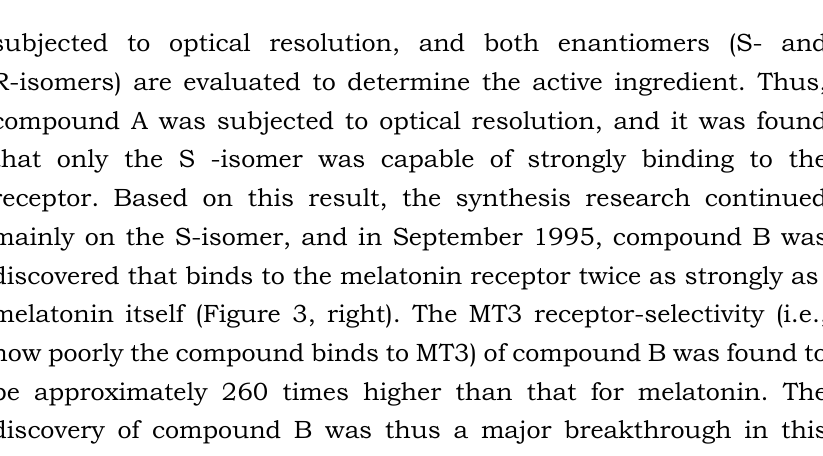
Figure 3. Structure of compound A and B Source: Uchikawa and Okawa